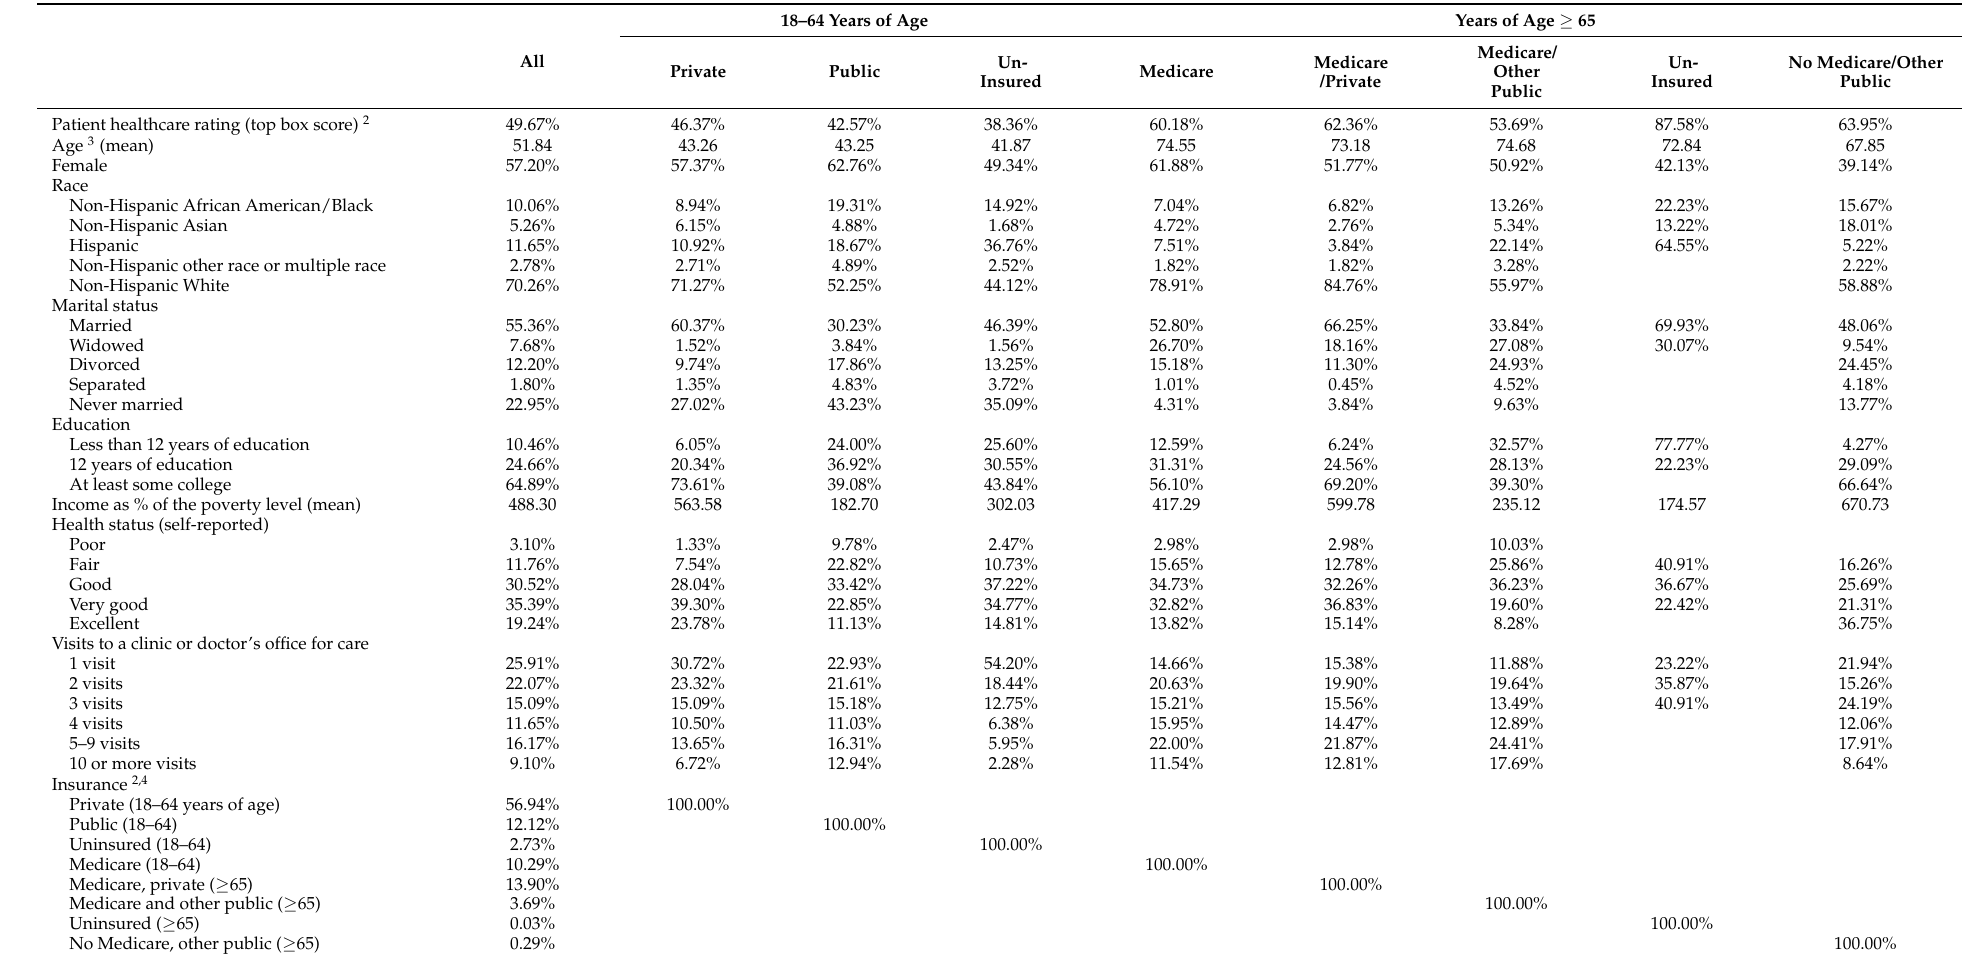
Table 1. Weighted means/percentages 1 of the model variables by health insurance